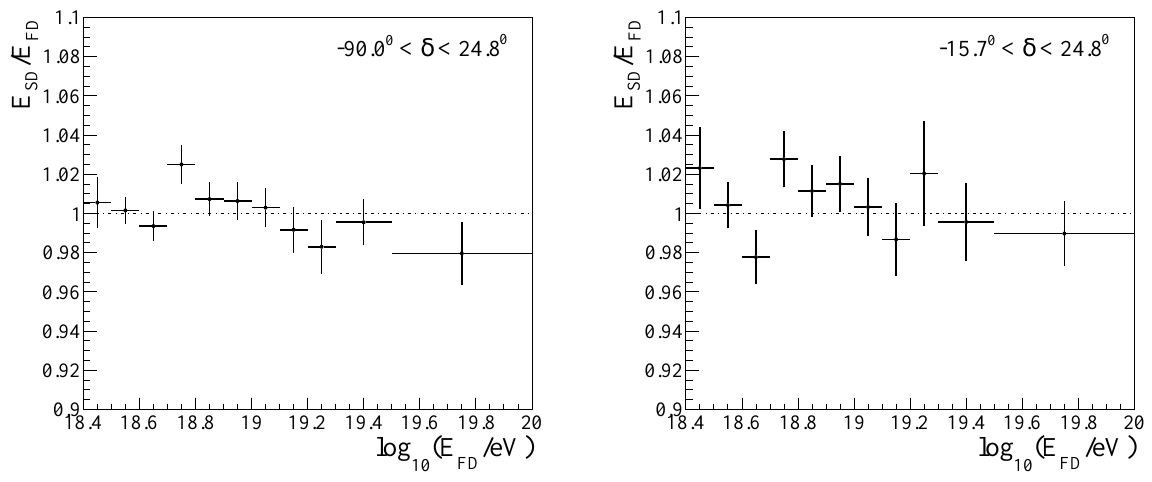
Figure 8. Ratio of the energies reconstructed by the Auger SD and FD plotted versus the logarithm of energy. The left panel shows the Auger SD and FD energy ratio for the entire Auger field of view, and the right panel shows the ratio of SD to FD energies for the Auger-TA common declination